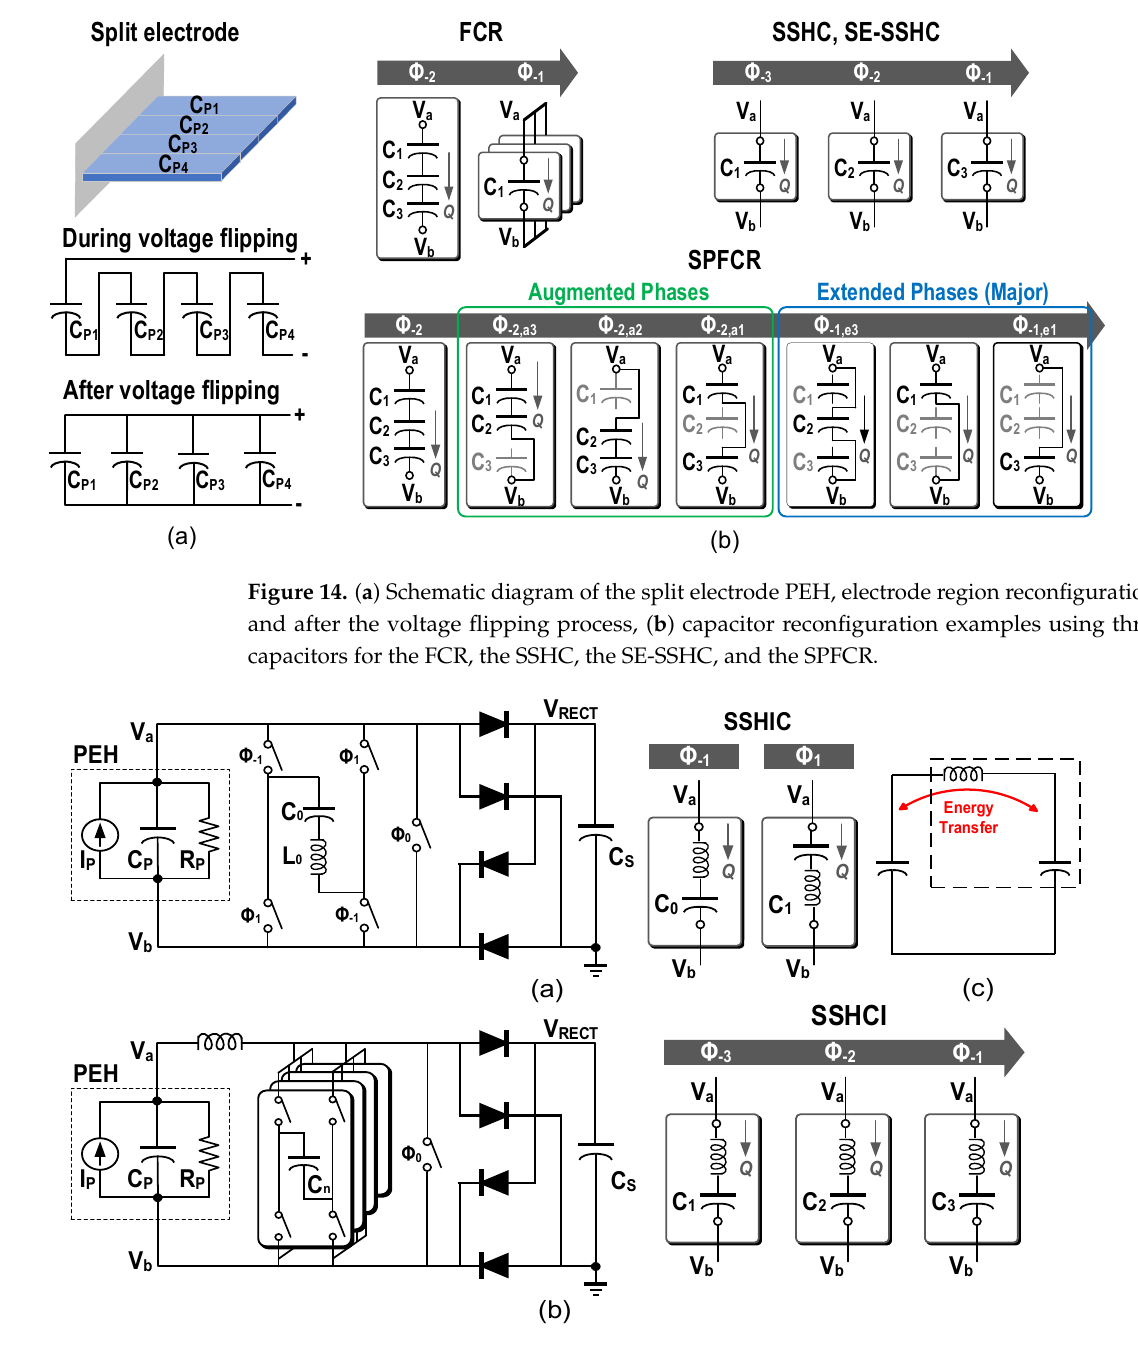
Figure 15. Interface circuit structures and hybrid reconfiguration examples of ( a ) the SSHCI, ( b ) the SSHIC. ( c ) Energy transferred model for hybrid flipping. Table 3. Comparison for the non-linear methods based on the SECE and the SSH.